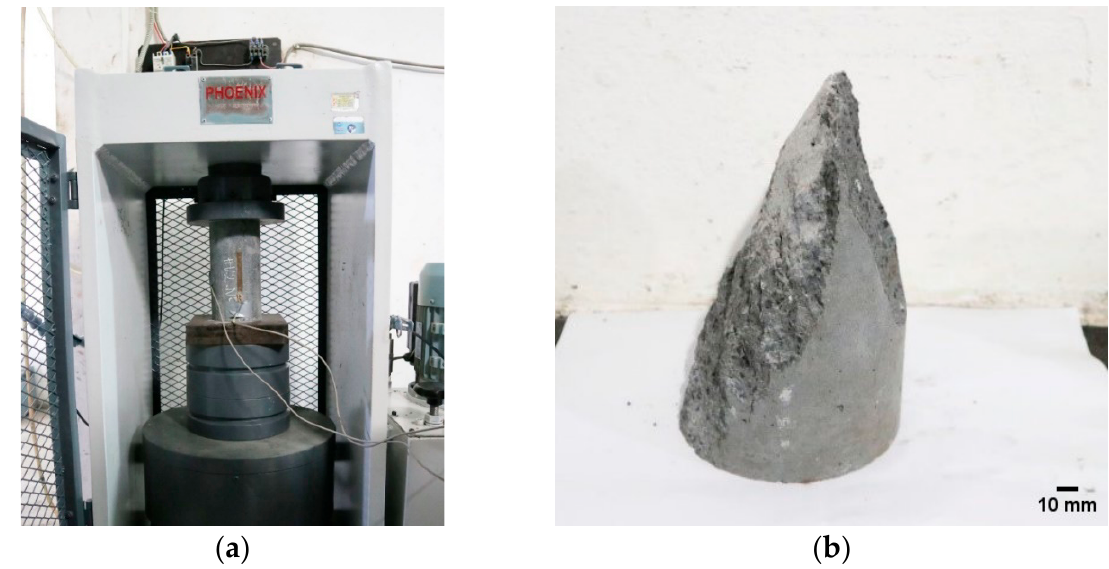
Figure 13. Compressive testing. ( a ) Specimen, ( b ) The shape of a sample after testing.